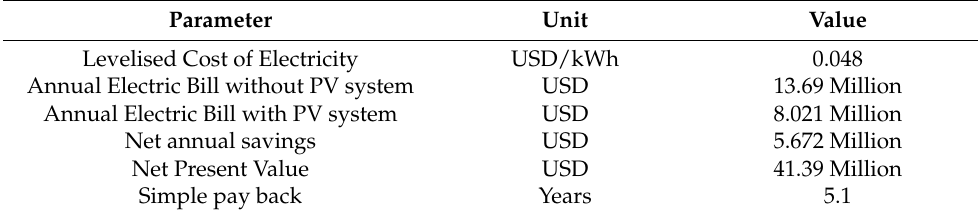
Table 15. Economic performance indicators for the PV system.